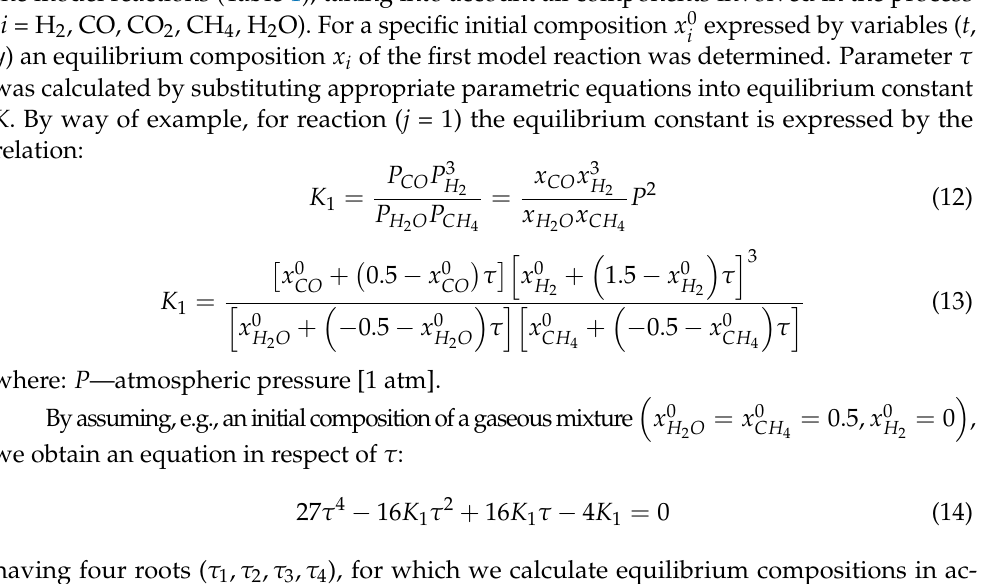
Figure 1. Initial composition ( x 0 and y .